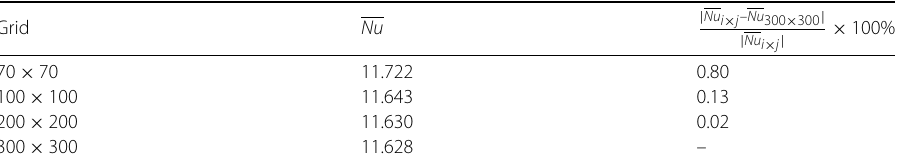
Table 6 Variation of Nu with the grid, Ra = 1000, Bi = 100, nonuniform grid Grid